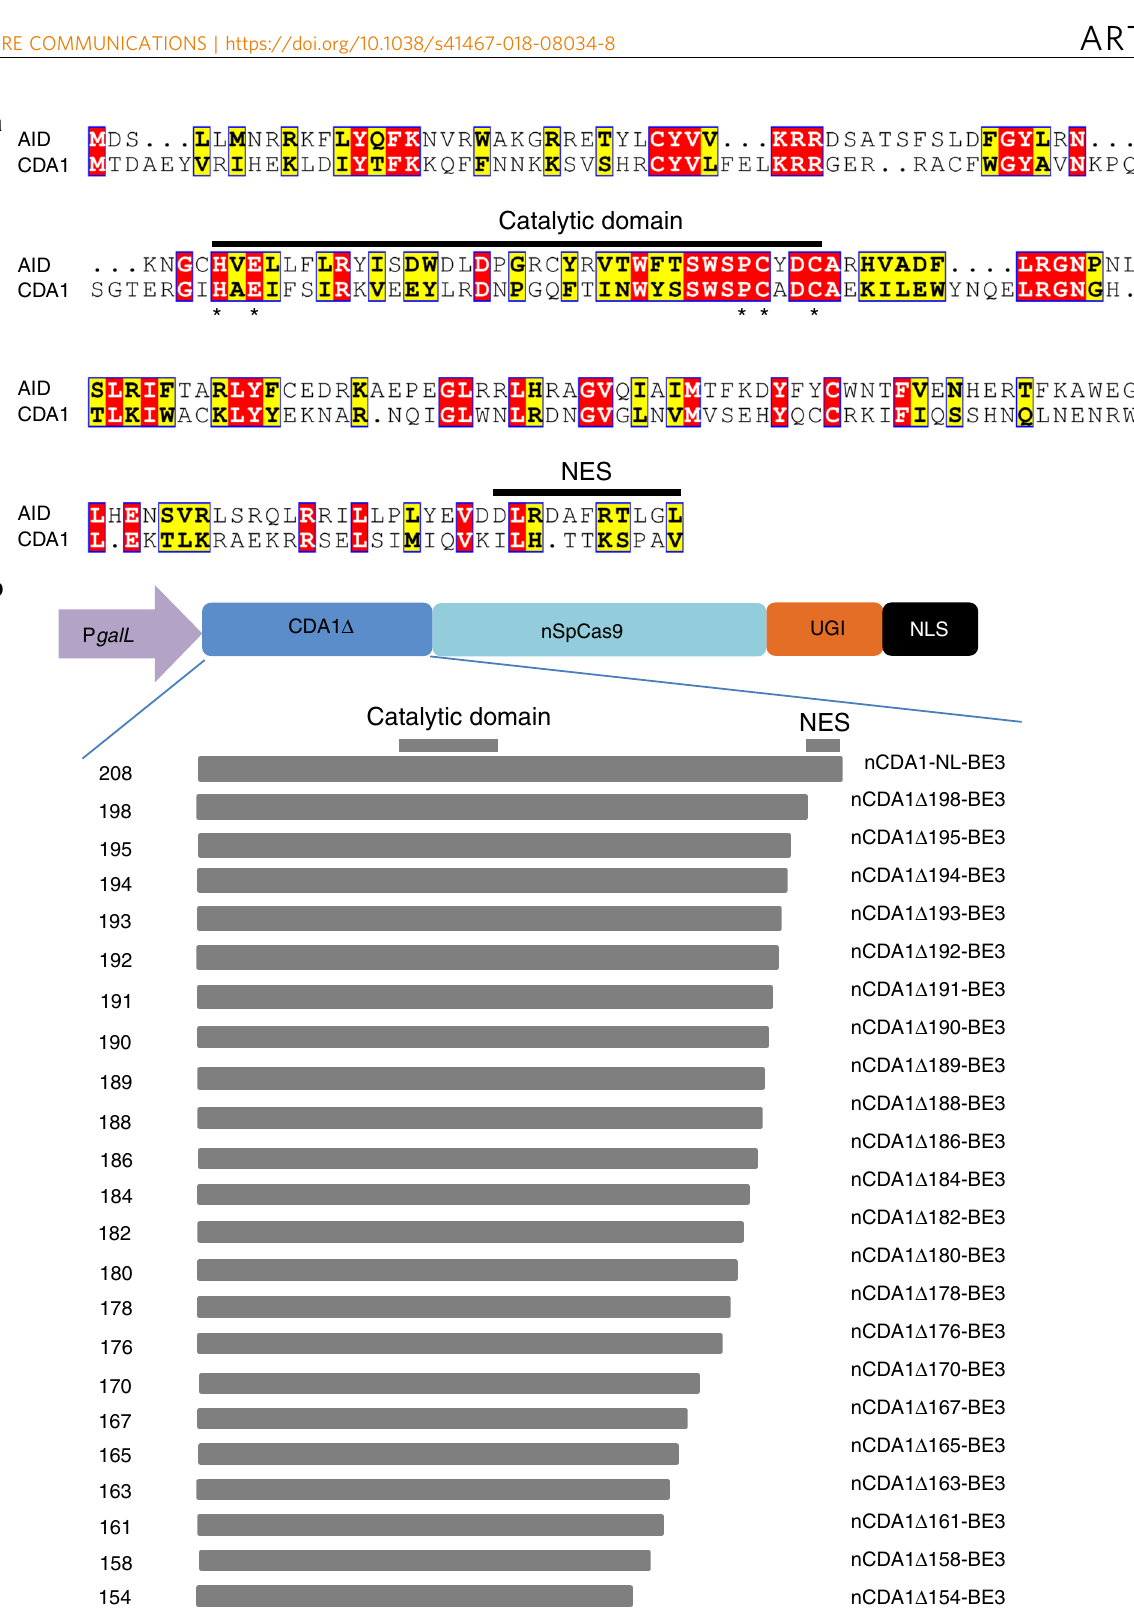
Fig. 3 Design of base editors with truncated CDA1 domains. a Amino acid sequence alignment of CDA1 and human AID. The catalytic domain HxE-PCxxC and the nuclear export signal (NES) are indicated by black horizontal lines. The alignment was created by CLUSTALW (ref. 38 ; https://www.genome.jp/ tools-bin/clustalw) and graphically formatted with the help of the ESPript 3.0 server 39 (http://espript.ibcp.fr/ESPript/ESPript/). Identical amino acid residues are shaded in red, similar residues in yellow. b Schematic representation of base editors with C-terminal CDA1 truncations (named after the last CDA1 residue